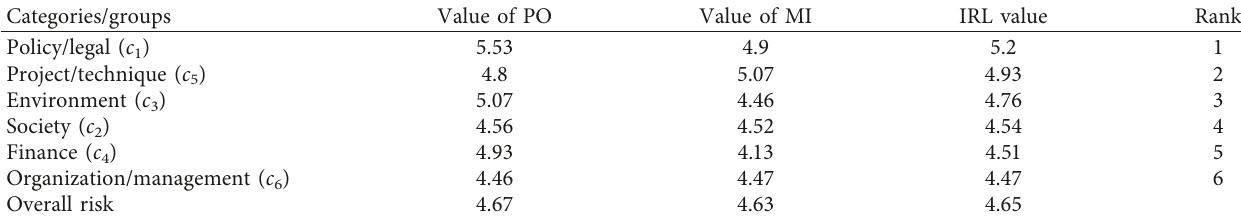
Table 8: The PO, MI, and ORL of CSRGs and the project.